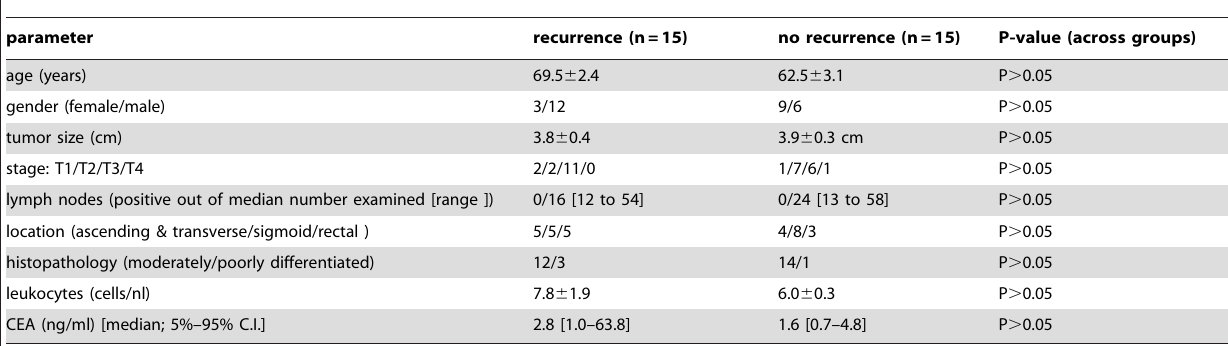
Table 1. Patient characteristics in the validation study.